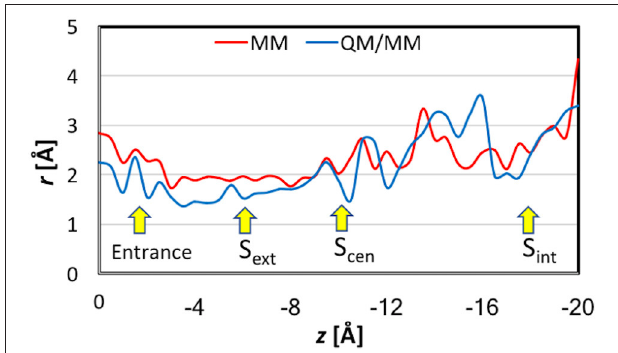
FIGURE 6 | Pore sizes at the locations of the Cl − ion in the umbrella sampling simulations. For each location, the reported radius is the average over seven representative